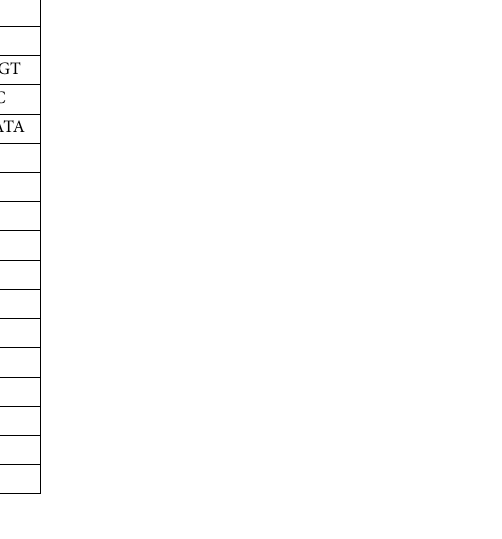
Table 1. List of SYBR green